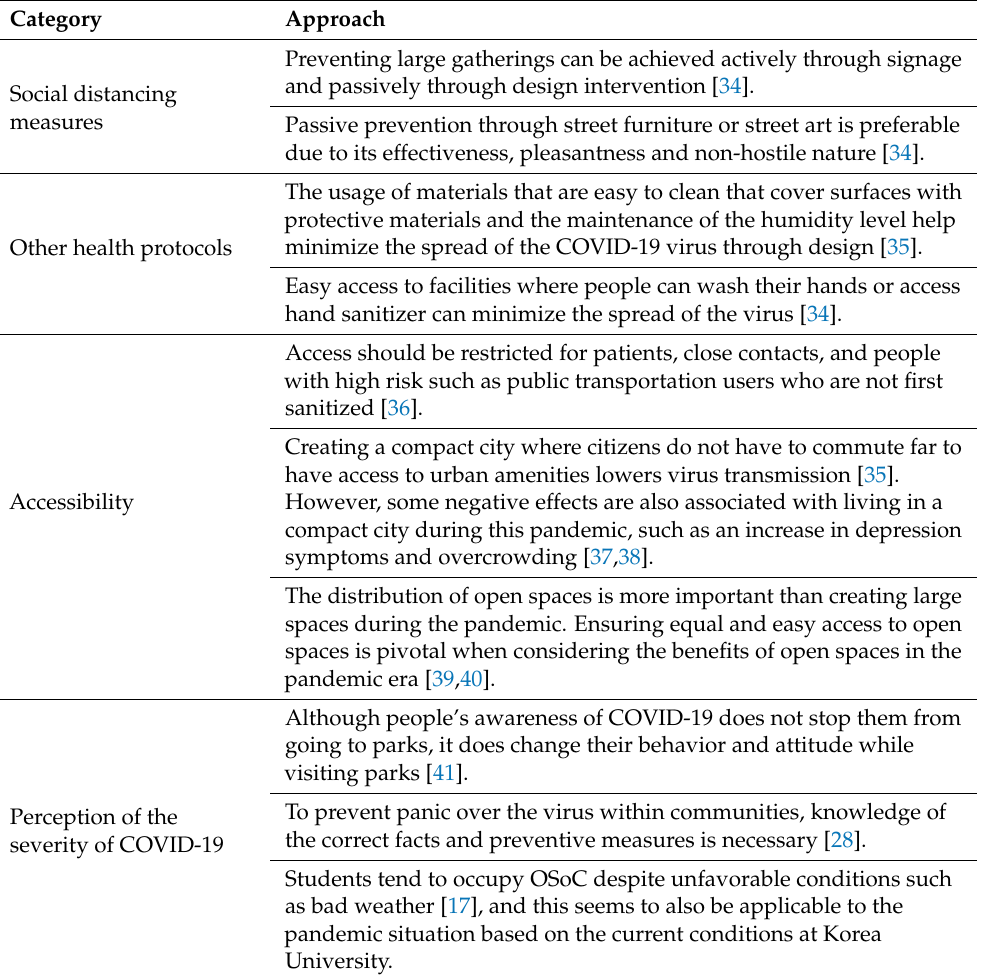
Table 1. Summary of the strategies for creating spatial adaptation in OSoC and Public Open Spaces during the